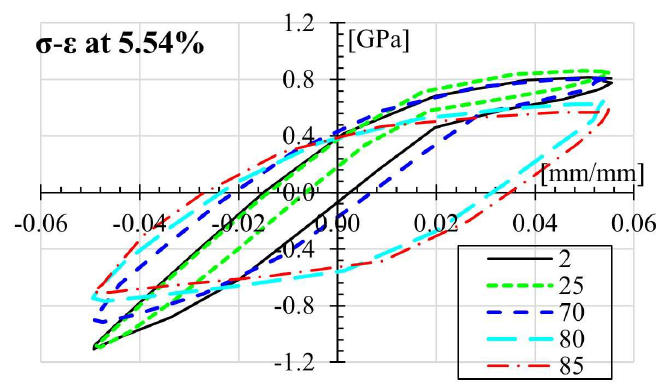
Figure 6. Exemplary result for the hysteresis loops at ± 5.54% ε .